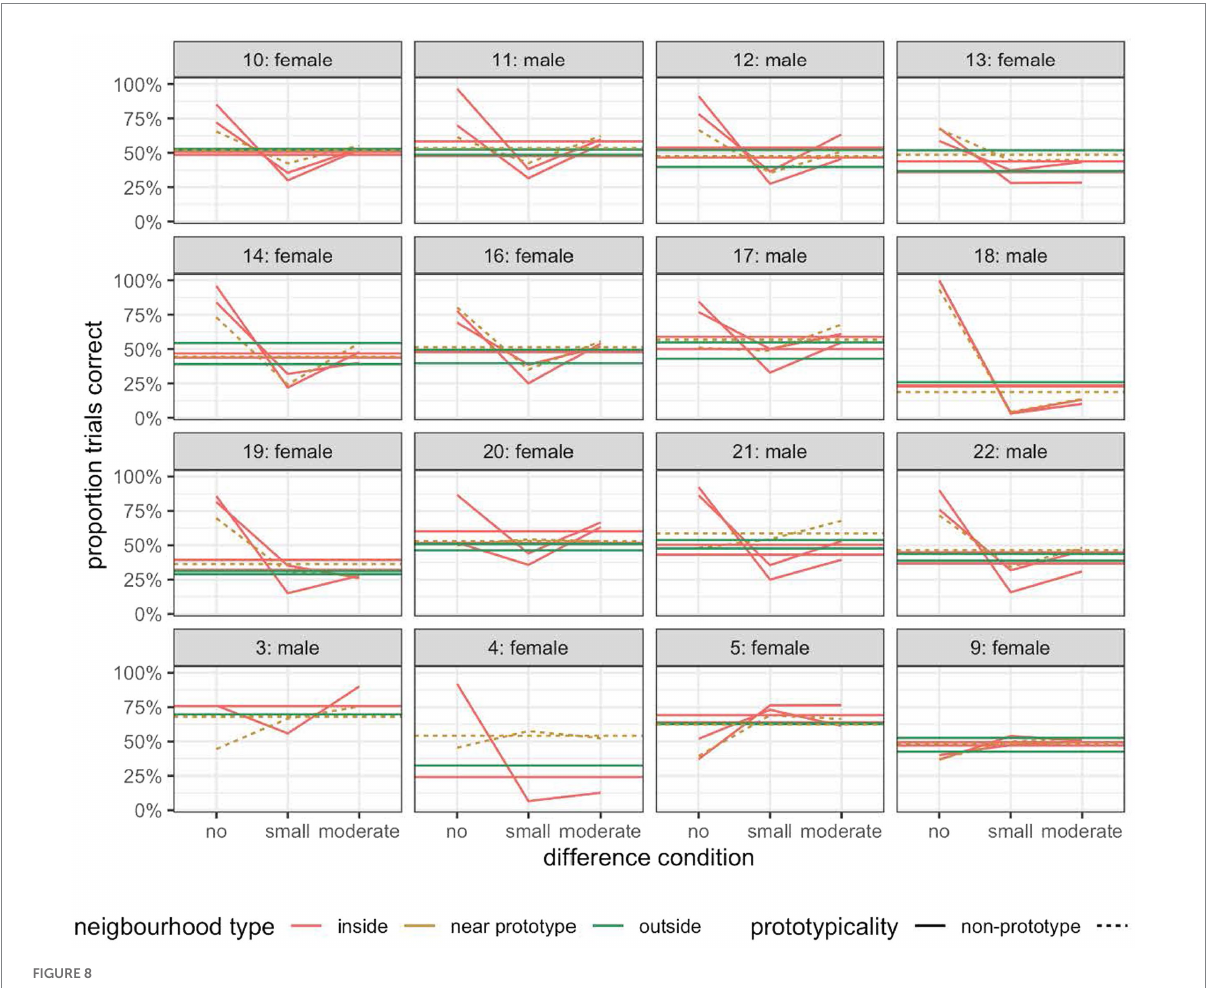
FIGURE 8 The percentage of trials with a correct response for each participant in Experiment